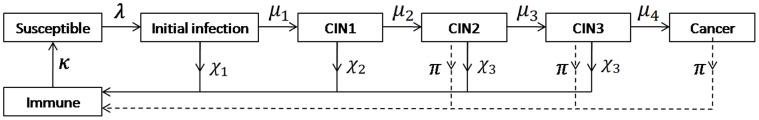
The Susceptible-Infectious-Recovered-Susceptible (SIRS) model of high-risk Human Papillomavirus (HPV) transmission and potential consequent progression to cervical cancer.Susceptible individuals become infected at a rate proportional to the force of infection λ. Following infection, they may progress in a stepwise fashion to neoplastic lesions of increasing severity (CIN1, CIN2, CIN3) and then to cancer (with rates ). Alternatively, they may spontaneously clear the infection from any pre-cancerous stage (with rates ). High-grade clinical lesions (CIN2 and CIN3) may be identified by cytological screening and successfully treated (at a rate π). Following viral clearance or successful treatment of lesions, women retain an immunity to re-infection with the same HPV type. This immunity wanes at rate κ, precipitating a return to the Susceptible compartment.